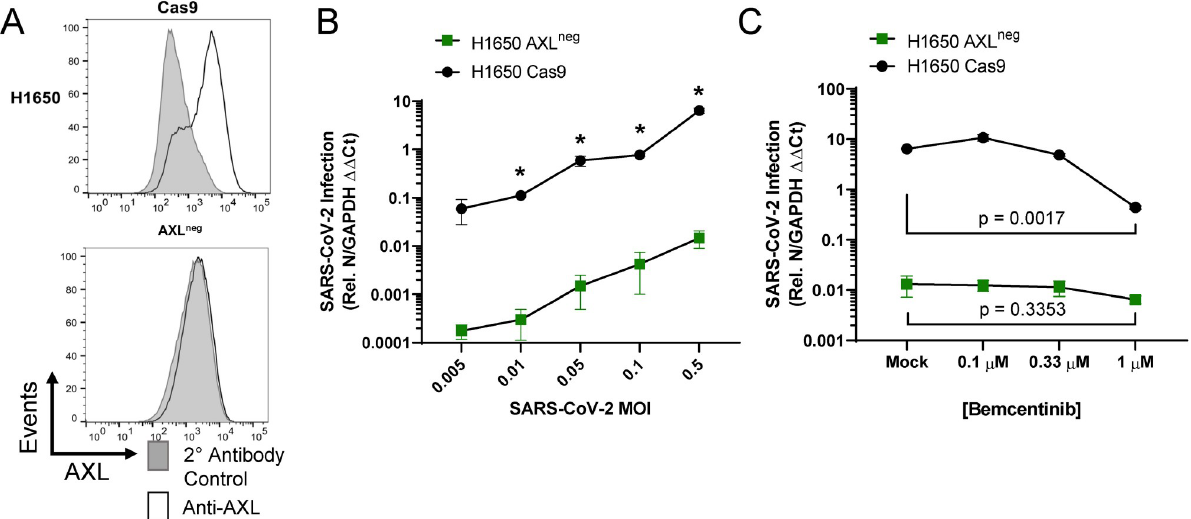
Fig 6. AXL knockout reduces viral loads and ablates inhibition by bemcentinib. A) Flow cytometry histograms depicting AXL surface staining (black) and secondary only background (gray) on parental, Cas9 expressing H1650 cells or Cas9/guide RNA treated and cloned cells, demonstrating loss of AXL expression. H1650 AXL knockout cells were generated by lentiviral transduction of Cas9 and gRNA targeting AXL, followed by selection, enrichment, and biological cloning. B) H1650 AXL neg and H1650 Cas9 (parental) lines were challenged with SARS-CoV-2 at indicated MOIs. At 24hpi, viral loads were assessed by RT-qPCR. C) H1650 parental and AXL neg lines were treated with the indicated concentration of bemcentinib and challenged with SARS-CoV-2 (MOI = 0.5) and viral loads determine by RT-qPCR 24 hpi. Data are pooled from 3 independent experiments ( B , C ) or are representative of at least 3 experiments ( A ). Data represented as means ± SEM. Multiple t-tests; asterisks represent p < 0.05 ( B ). Student’s t-tests comparing Mock and 1 μ M; p values shown ( C